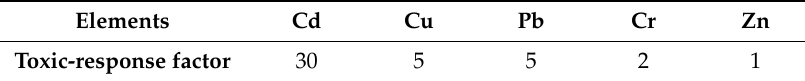
Table 2. Toxic-response factor by Håkanson